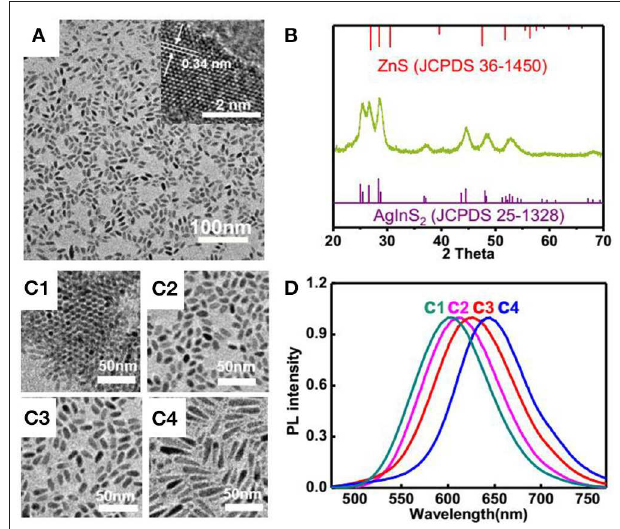
FIGURE 3 | (A) TEM and HRTEM (inserted) images and (B) XRD patterns of ZAIS nanoparticles; (C) TEM images of ZAIS with different dosages of